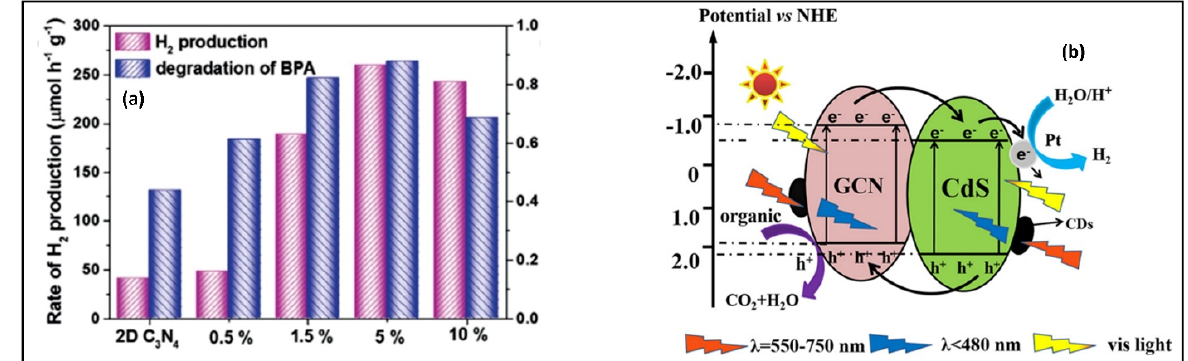
Figure 16. ( a ) Production of H 2 with simultaneous degradation in the presence of bisphenol A pollutant (BPA) over 2D C 3 N 4 coupled with different amounts of 2D BP. Reprinted with permission from reference [256]. Copyright 2019 Elsevier B.V. ( b ) Illustration for the Photocatalytic Mechanism over the 3%CDs/10%CdS/GCN Catalyst under visible-light irradiation. Reprinted with permission from reference [257]. Copyright 2018 Royal Society of Chemistry.